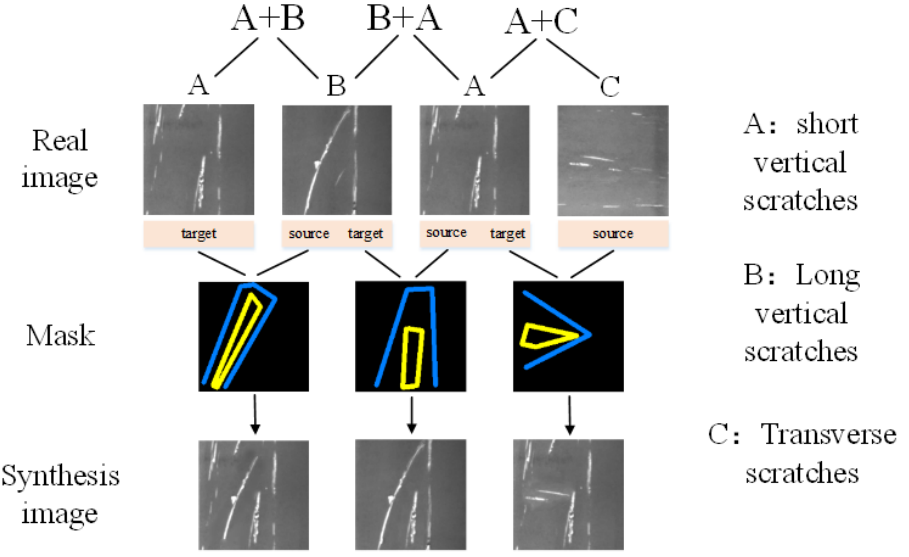
Figure 12. Three kinds of scratch defect image cu tt ing and splicing.